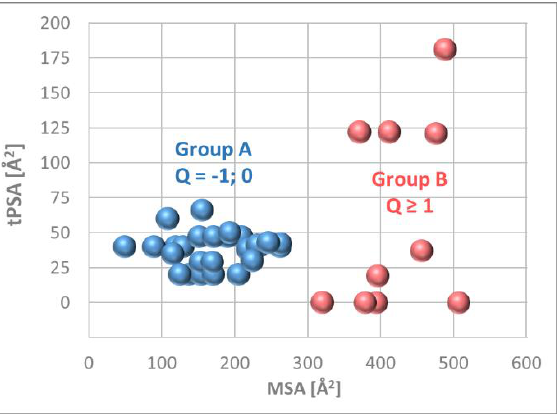
Figure 1. Two-dimensional plots of total polar surface area (tPSA) vs. Connolly molecular surface area (MSA): position of preservatives reveal two distinctive areas in chemical space for neutral or anionic (blue) and cationic (red) substances.